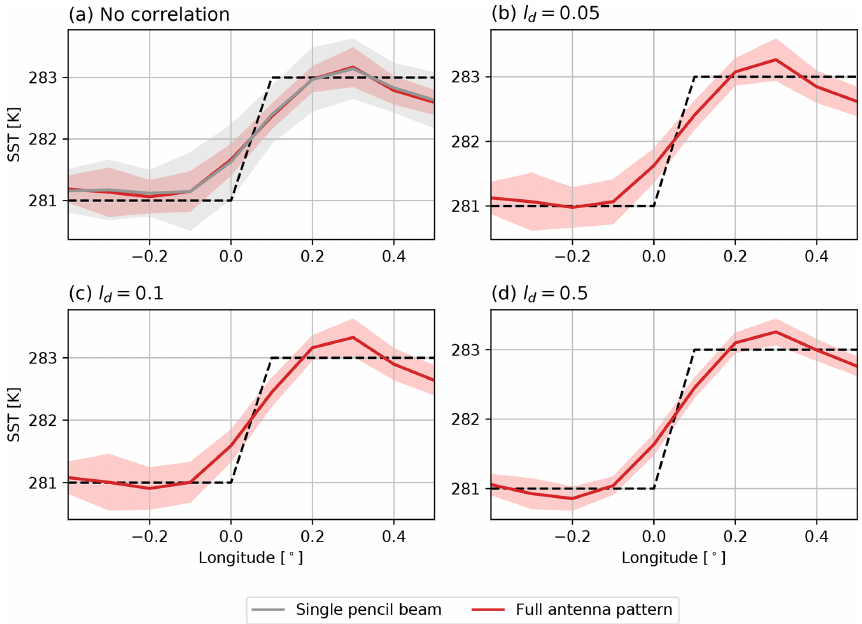
Figure 11. A synthetic scene as in Fig. 3, but with the background defined by a step function in SST, shown by the dashed line and consistent across latitudes. The shaded areas represent the spread of retrieved SST in the latitudinal direction and the solid lines the